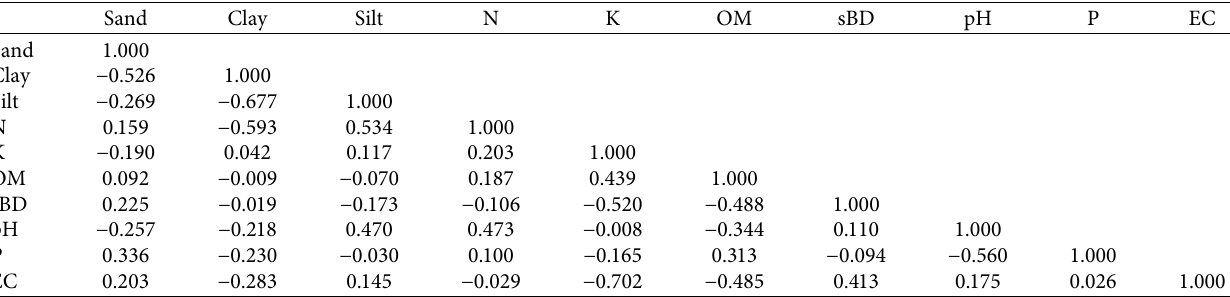
Table 2: Correlation matrices between physicochemical properties of bottom sediments of Maruba